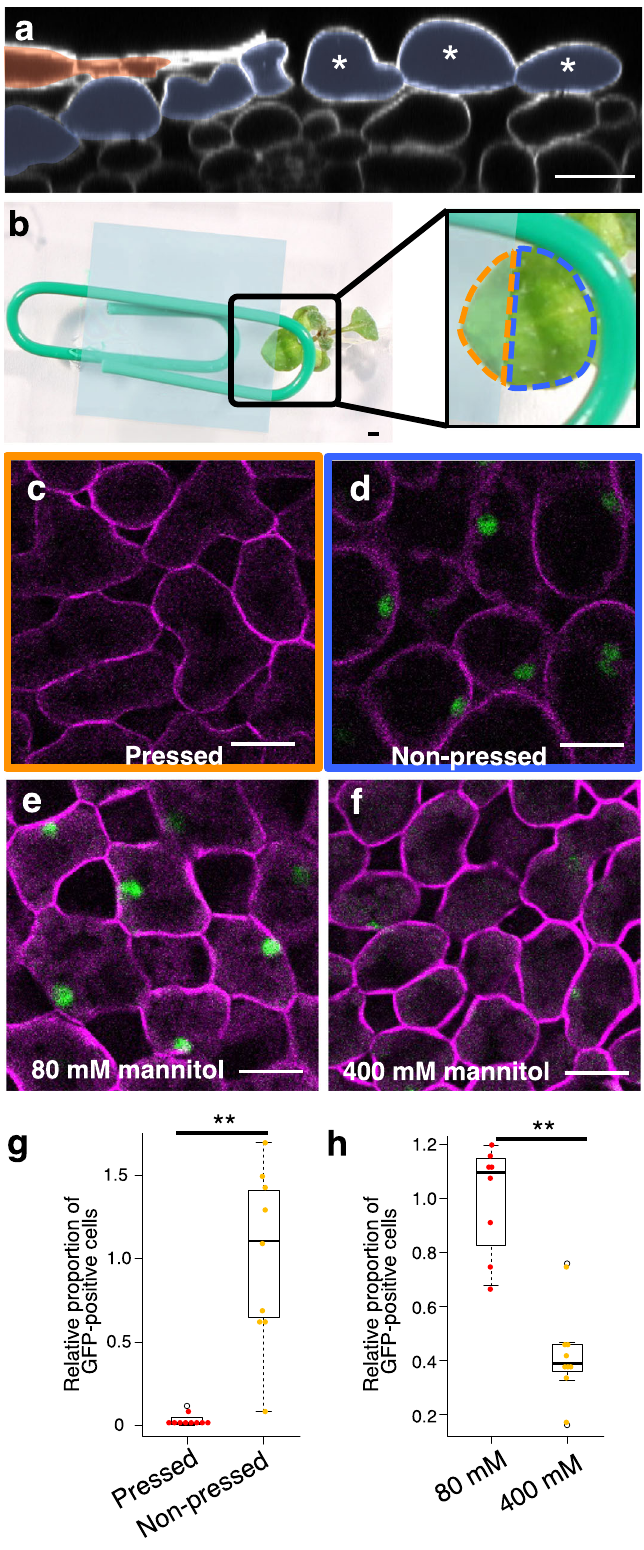
Fig. 2 | ATML1 induction in mesophyll cells was repressed by mechanical pressure and under hyperosmotic conditions. a Optical transverse section of a 10-day-old proATML1-nls-3xGFP leaf at 1 dar. Red, epidermal cells; blue, mesophyll cells; asterisks, outermost mesophyll cells. b After epidermis peeling, the fi rst or second leaf of a 9-day-old proATML1-nls-3xGFP seedling was placed between two coverslipsandpressedwithapaperclip.Theorangedashedregion,pressedregion; thebluedashedregion,non-pressed region. c , d proATML1-nls-3xGFP signalsinthe outermost mesophyll cells in the pressed ( c ) and non-pressed ( d ) regions at 1 dar. e , f proATML1-nls-3xGFP signals in the outermost mesophyll cells of 10-day-old seedlings grown in 80mM ( e ) and 400mM ( f ) mannitol-containing liquid MS medium for 24h after surgery. Experiments in a and c - f were repeated three times with similar results. g , h The relative proportion of mesophyll cells showing GFP signals above the thresholdwas quanti fi ed inthe pressed and non-pressed regions ( g )and in80mMand 400mM mannitol-treated seedlings( h ). n =nine biologically independent leaves except for 80mM in h ( n =eight). Two-tailed Wilcoxon rank- sum test was used (** P <0.01). In the box plots, the 25th percentile, the 50th per- centile(centralvalue)andthe75thpercentilearemarkedbyhorizontallineswithin the box. The ends of the whiskers indicate the maximum and minimum values within 1.5xIQR from the box ends. Outliers are shown above and below the whis- kers. Green, GFP; magenta; FM4-64. Scale bars: 20 µ m in a , c – f ; 1mm in b